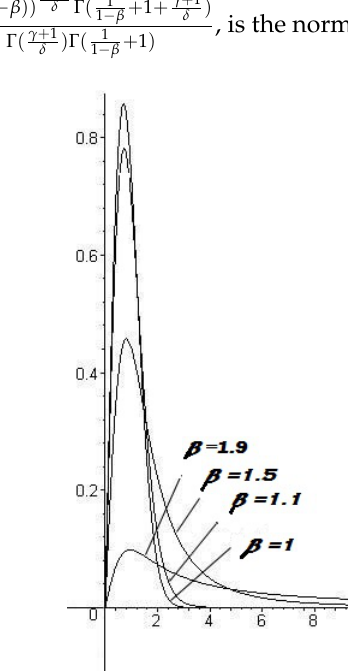
Figure 1. The graph of g 1 ( x ) , for γ = 1, a = 1, δ = 2, η = 1 and for various values of β